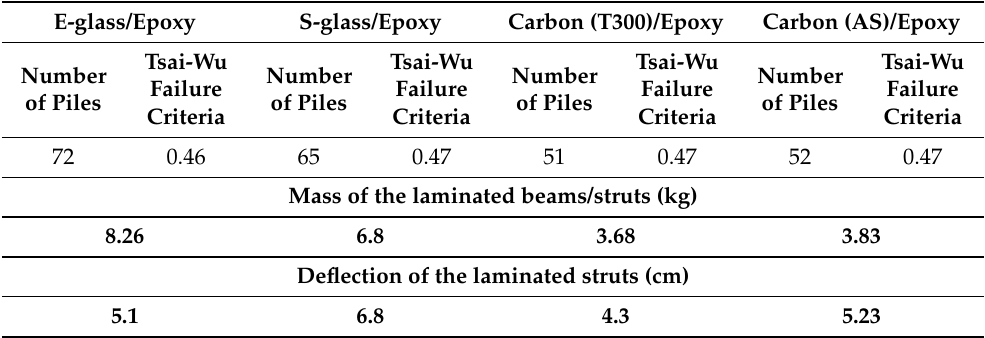
Table 4. Results of thick laminated composite beams under bending load of 35,000